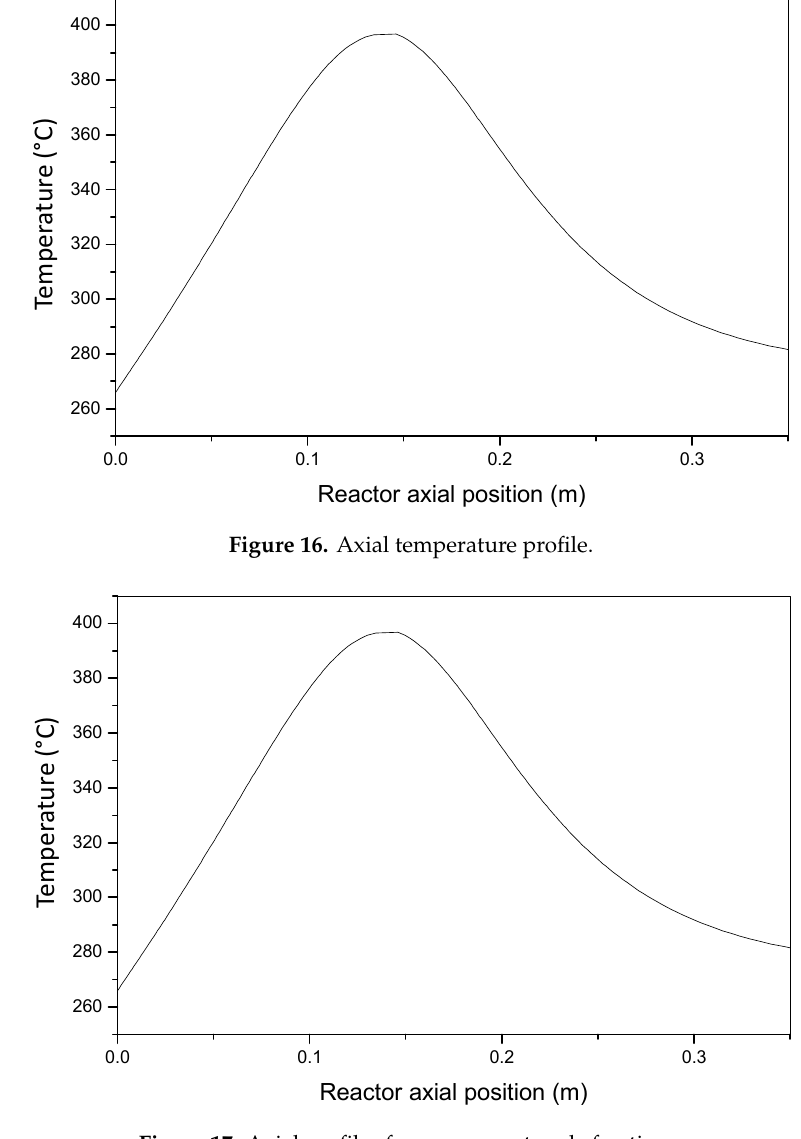
Figure 16. Axial temperature profile. Figure 17. Axial profiles for component mole fractions.